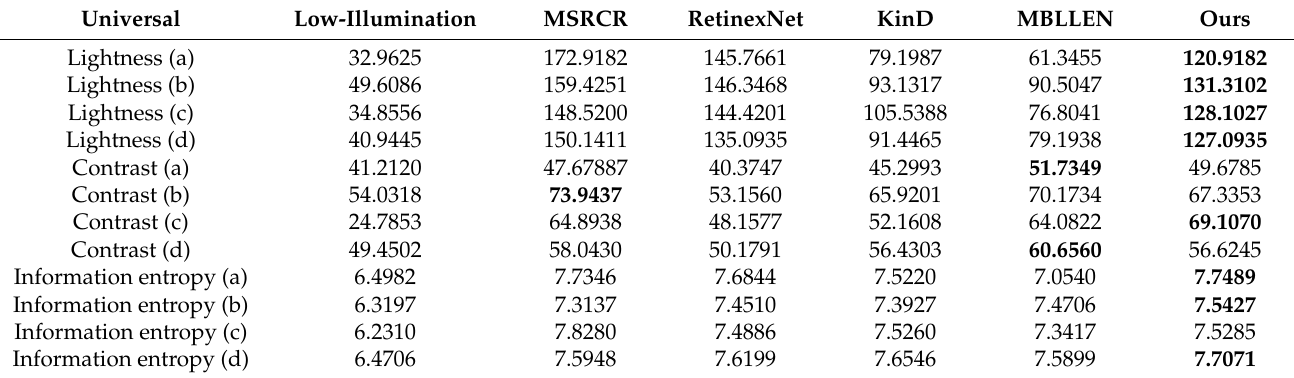
Table 5. Performance comparisons of the algorithms in general pictures under low illumination.